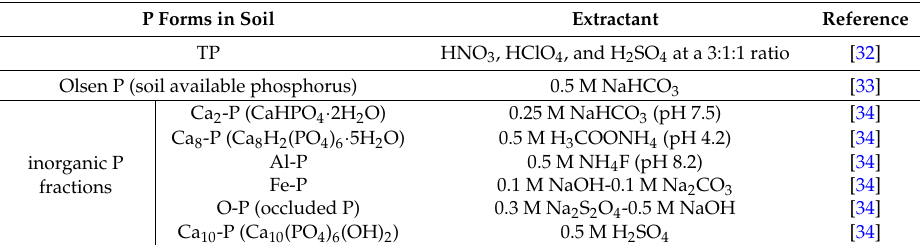
Table 1. Analysis methods of P forms in soil.